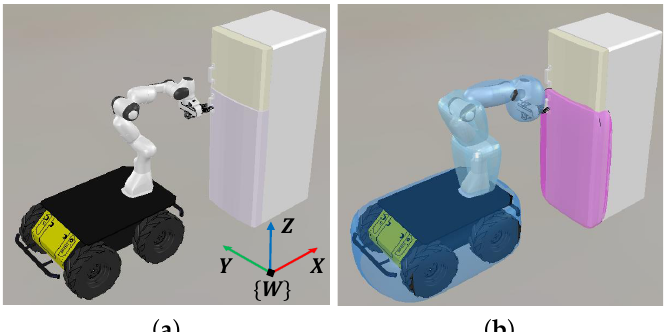
Figure 16. ( a ) Illustration of the scenario of the mobile manipulator opening a refrigerator; ( b ) collision models including the door of the refrigerator are shown. The collision model for the door is colored with magenta.